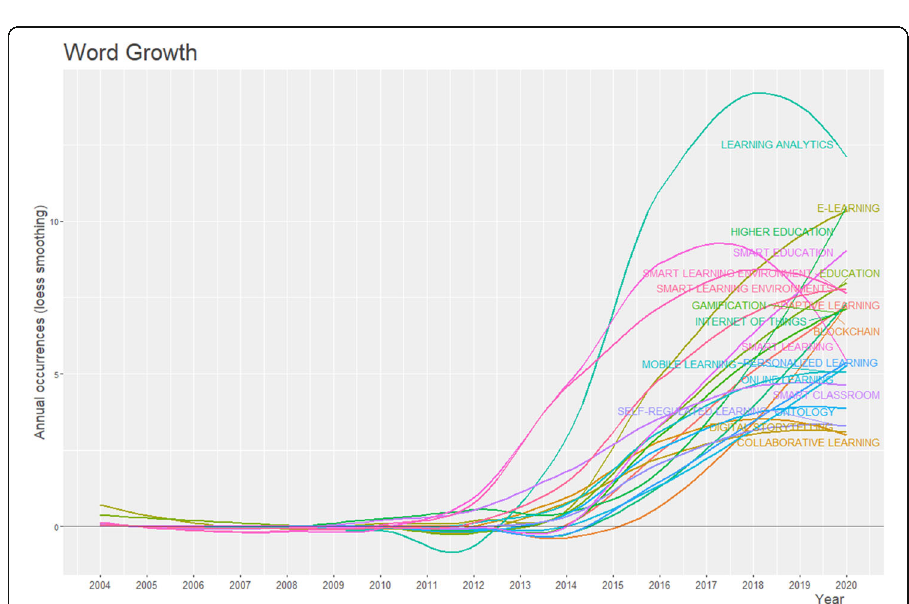
Fig. 9 Authors ’ keywords dynamic view over time: it shows the growth of keywords ; learning analytic has grown till 2018 and began to decline thereafter; however, higher education, personalized learning, internet of thing, and blockchain are keywords that show upward growth as of